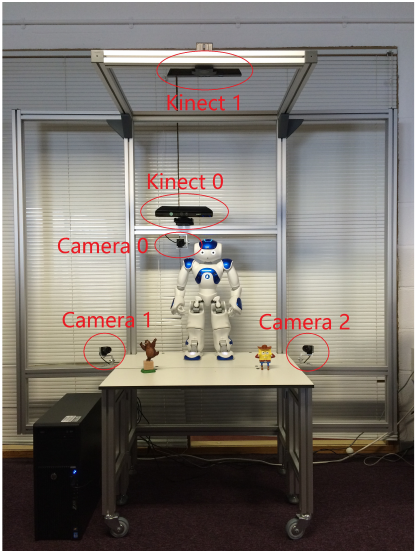
Figure 1: The intervention table and location of different cameras and